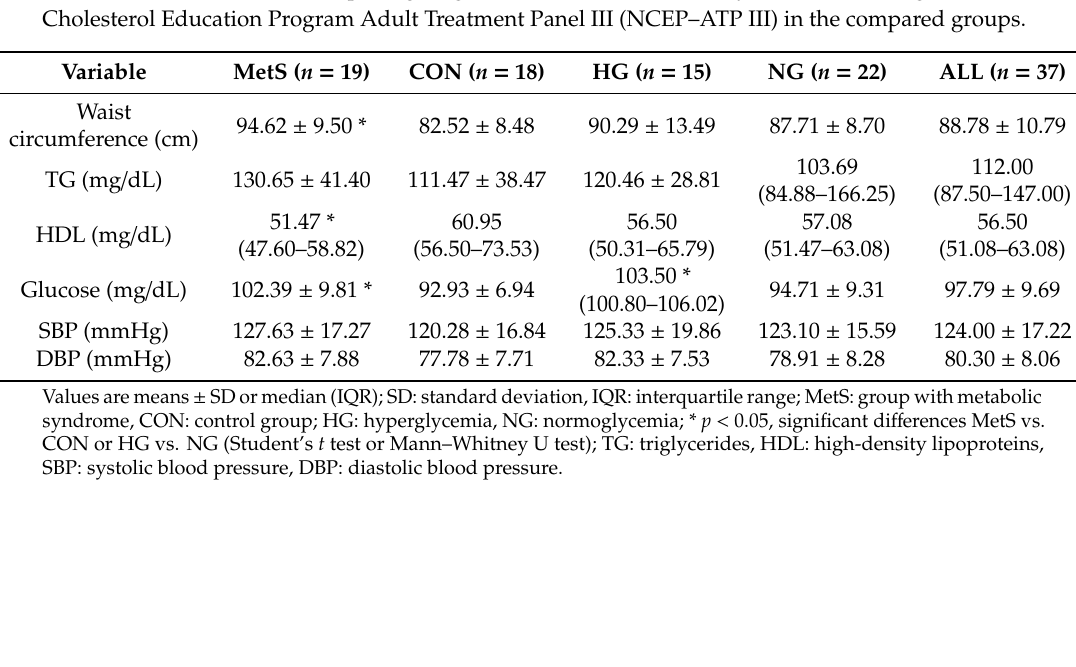
Table 2. Value of variables comprising diagnostic criteria of metabolic syndrome according to